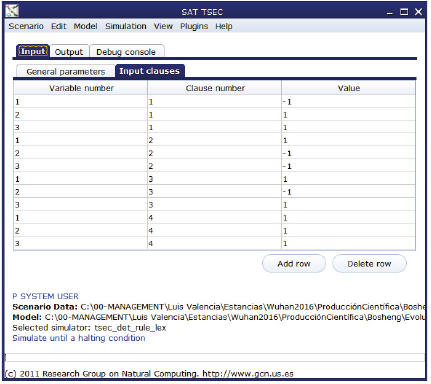
Figure 2: MeCoSim input table.